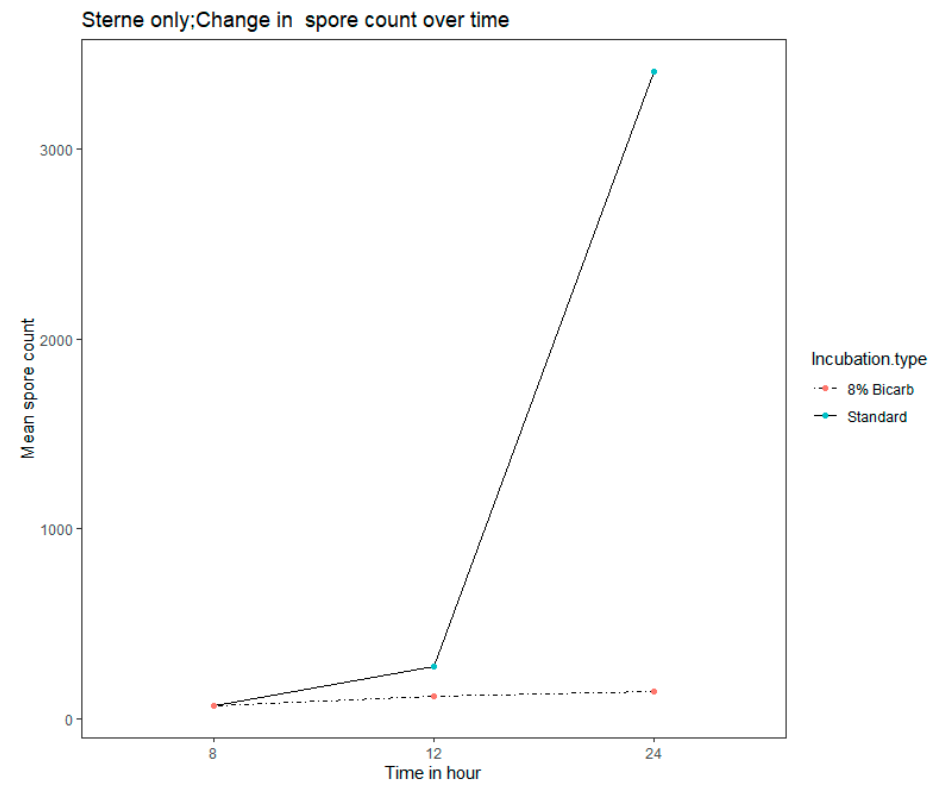
Figure A7. ( A ): Cell counts for Bacillus anthracis under standard conditions and with bicarbonate treatment. ( B ): Spore counts for Bacillus anthracis under standard conditions and with bicarbonate treatment. ( C ): Change in cell counts for Bacillus anthracis DS201579 under standard conditions and with bicarbonate treatment. ( D ): Change in cell counts for Bacillus anthracis Sterne under standard conditions and with bicarbonate treatment. ( E ): Change in spore counts for Bacillus anthracis DS201579 under standard conditions and with bicarbonate treatment. ( F ): Change in spore counts for Bacillus anthracis Sterne under standard conditions and with bicarbonate treatment.